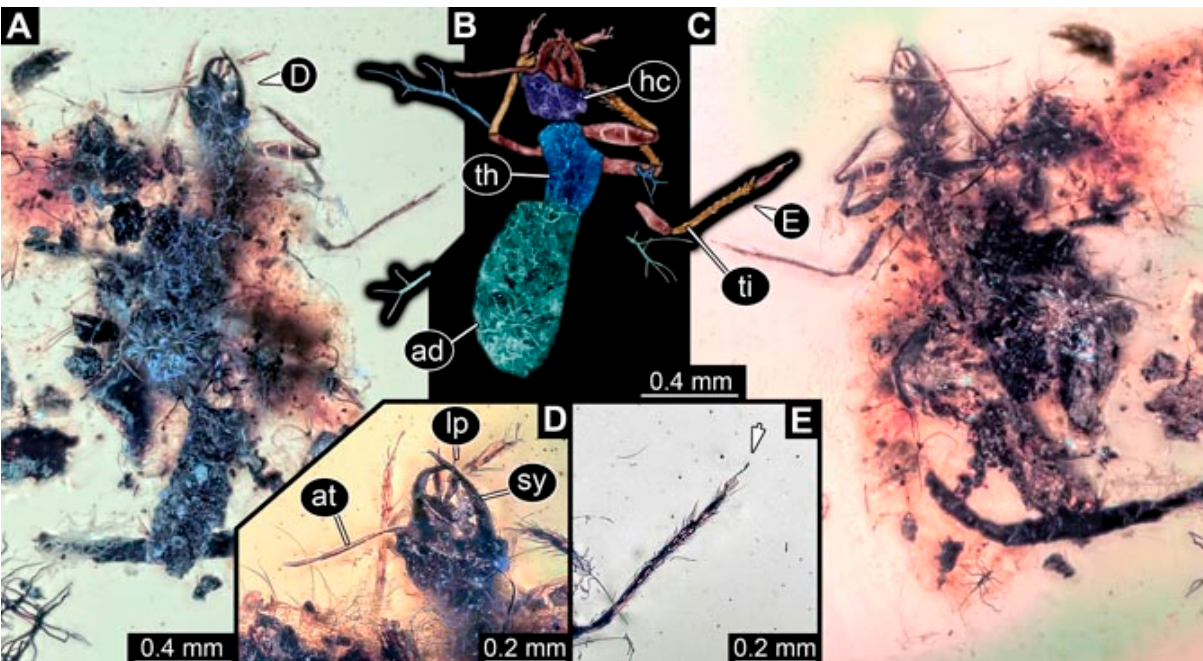
Figure 29. Specimen 4851 (PED 0696); Myanmar amber. ( A ) Dorsal view. ( B ) Dorsal view, colour- marked. ( C ) Ventral view. ( D ) Close-up of head capsule in dorsal view. ( E ) Close-up of trunk appendage with empodium (arrow). Abbreviations: at = antenna; ad = abdomen; hc = head capsule; lp = labial palp; sy = stylet; th = thorax; ti = tibia.